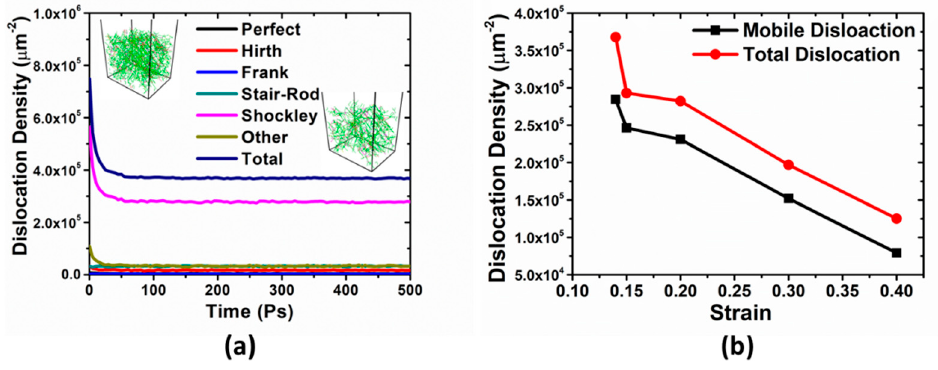
Figure 7. ( a ) Evolution of different types of dislocations during 500 ps equilibrium run before nanoindentations for prestrain 0.14. ( b ) Total and mobile dislocation density vs. prestrain.